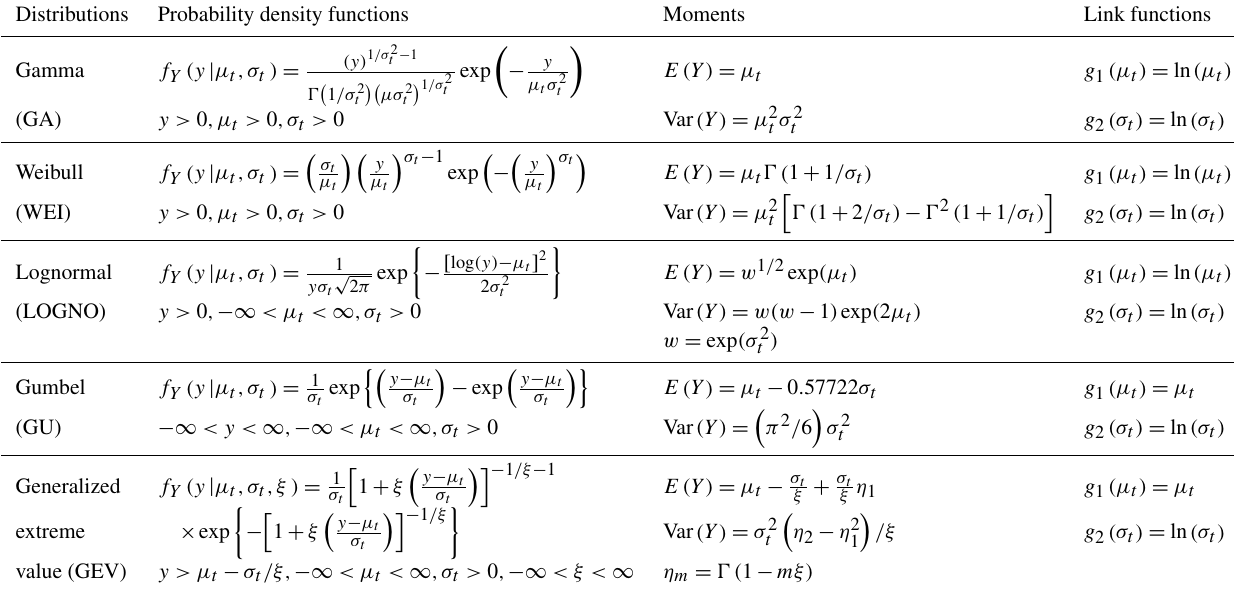
Table 1. Summary of the probability density functions, the corresponding moments, and the used link functions for nonstationary flood frequency analysis.